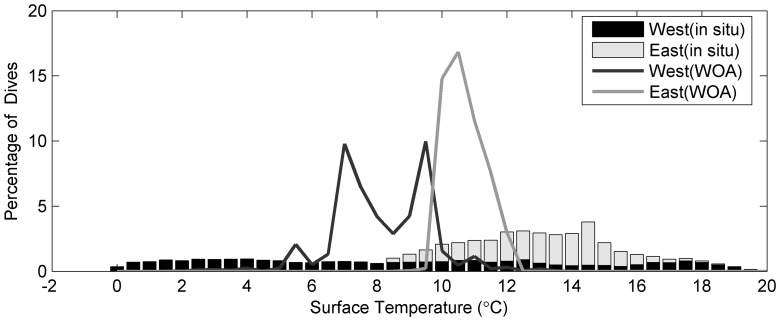
Annual mean surface water temperature experienced by grey seals.Binned surface water temperatures measured by SRDLs (bars) and calculated from the gridded SST data (lines) at the dive locations for grey seals east of 30°W (light coloured) and west of 30°W (dark coloured).